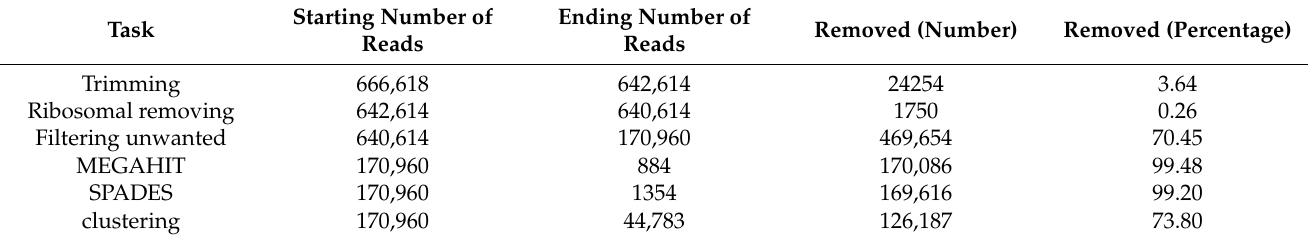
Table 4. PIMGAVir, numerical data flow of data during its execution.